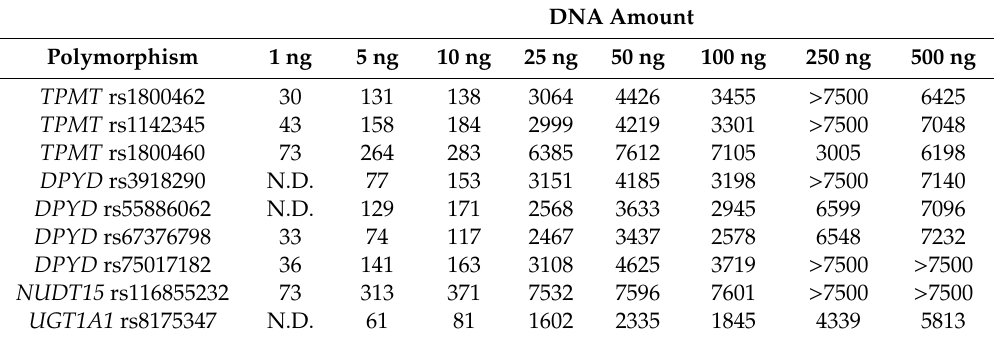
Table 3. Influence of the amount of DNA analyzed on the performance of the analysis.